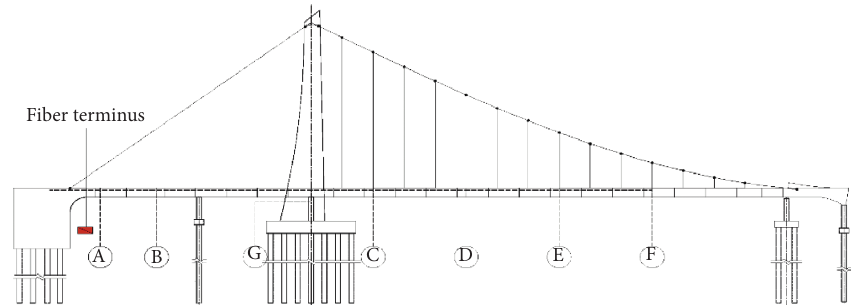
Figure 5: The layout of monitoring sections about Tianjin’s Fumin bridge [23, 36, 38].